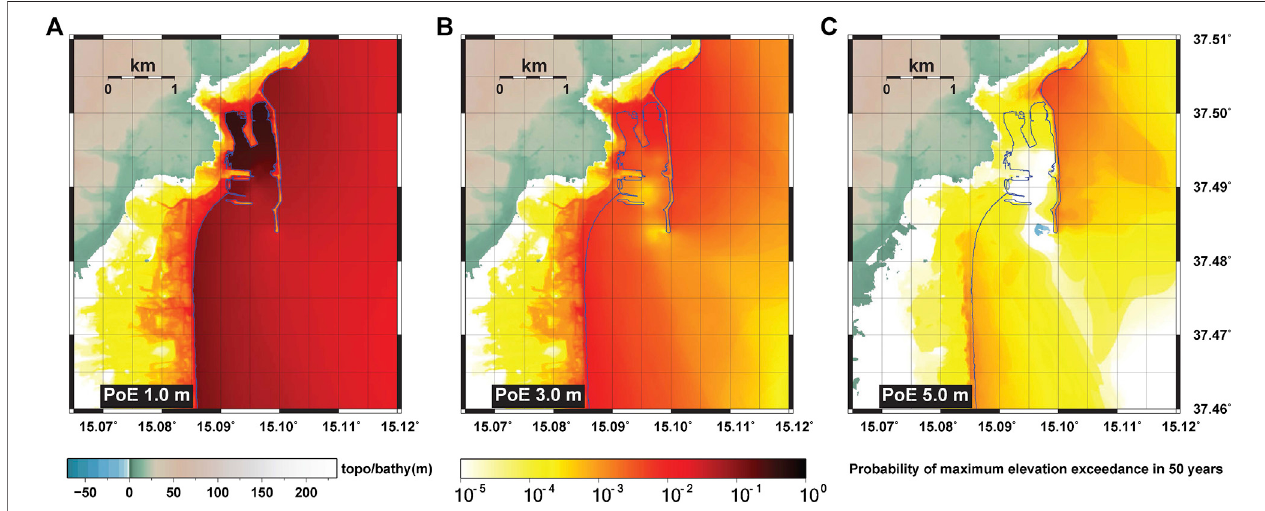
FIGURE 9 | Probability of exceedance within 50 years of maximum surface elevation (offshore) and MIH (onshore) of (A) 1 m (B) 3 m, and (C) 5 m, for Catania and neighboring areas. The zero-elevation contour line for the undeformed topography is shown in blue.